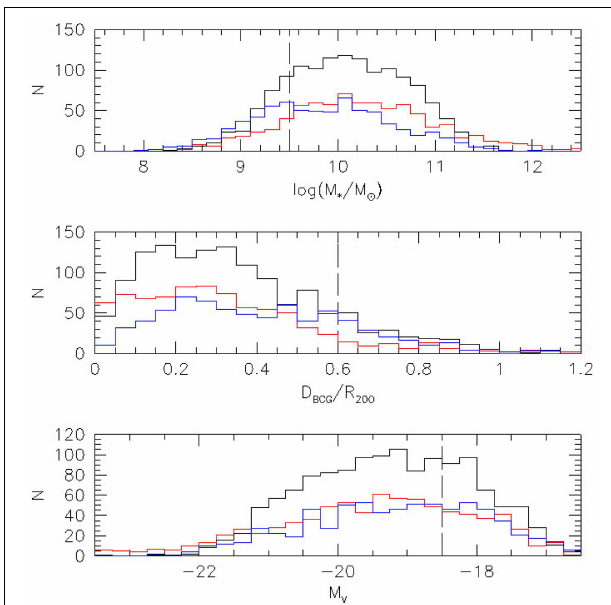
FIGURE 1 | From top to bottom we plot here the distribution of the galaxy stellar masses, the cluster-centric distance in R 200 units and the absolute magnitudes of the galaxies for the different morphological types: red lines mark the Elliptical galaxies, black lines the S0 galaxies, and blue lines Spirals. The vertical dashed black lines mark the limit where the WINGS data sample is 50 % ∼